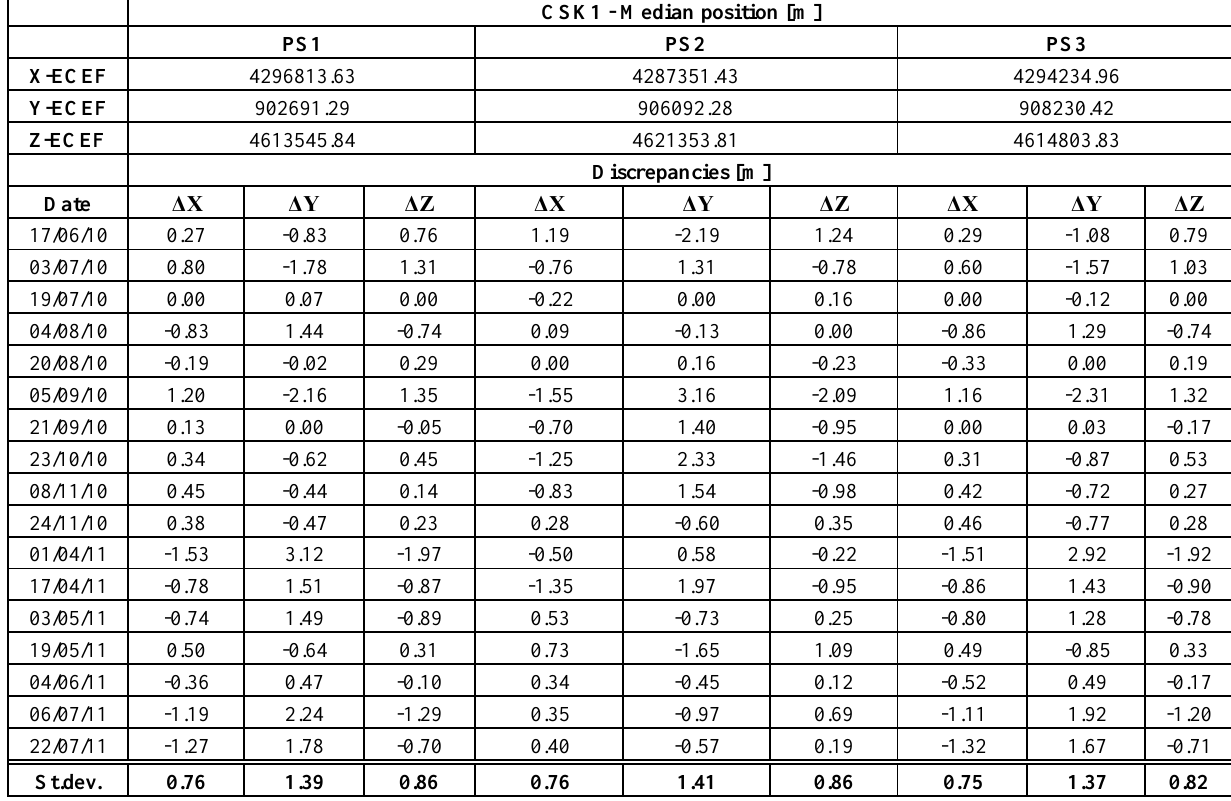
Table 1. PS’s estimated positions discrepancies for